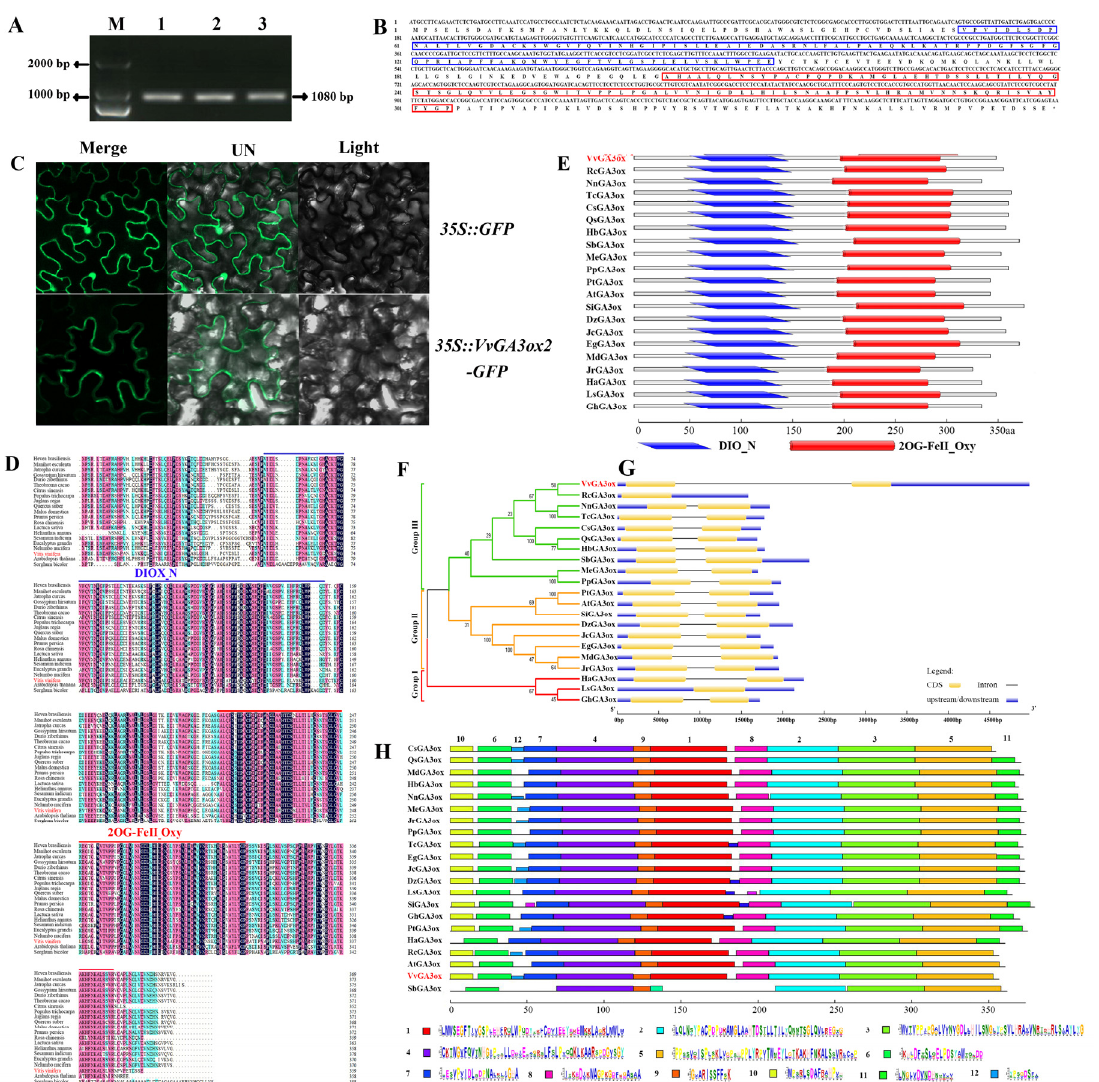
Figure 3. Sequence analysis and subcellular localization of target genes. Cloning of VvGA3ox2 ( A ); VvGA3ox2 amino acid sequence deduction ( B ); Subcellular localization ( C ); Alignment of GA3ox2 amino acid sequence homology and conserved domains in different species ( D , E ); GA3ox2 evolution- ary analysis ( F ); GA3ox2 gene structure analysis ( G ); Analysis of Conserved Motifs of GA3ox Protein Sequences in Different Species ( H